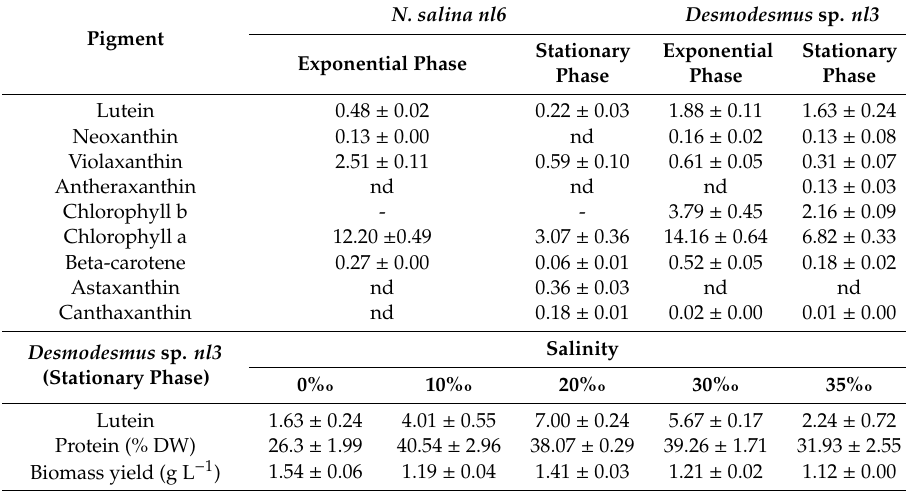
Table 2. Pigment content in exponential and stationary phase (mg / g DW). N. salina nl6 was cultivated in F / 2 medium (24% (cid:24) salinity) and Desmodesmus sp. nl3 on TAP medium; Lutein, protein, and biomass contents of Desmodesmus sp. nl3 (n = 3).